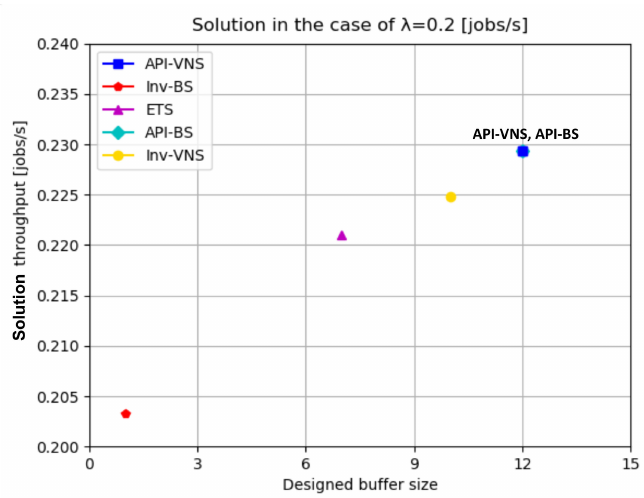
Figure 19. Scatter plot of designed bu ff er size vs. solution throughput for the five methods in the case of λ = 0.2 in experiment 2.